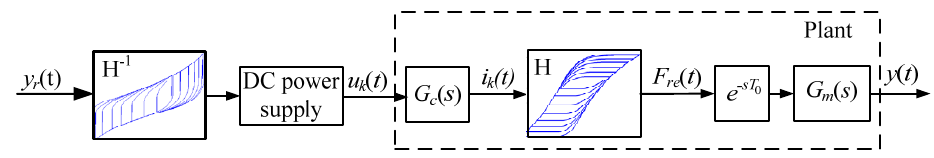
Figure 16. Block diagram of open-loop control system.